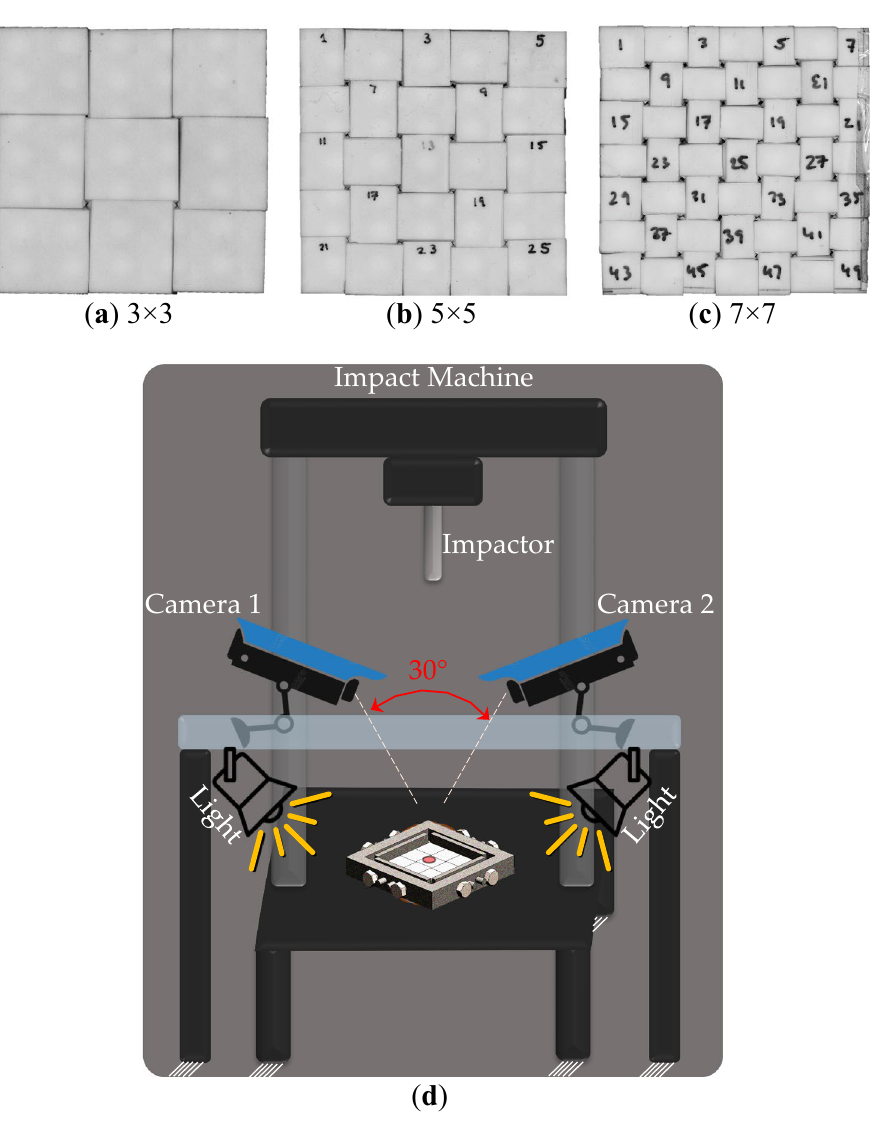
Figure 3. Topologically interlocked ceramics: ( a ) 3 × 3, ( b ) 5 × 5, ( c ) 7 × 7 arrays of blocks (30°), and ( d ) low- velocity impact test and DIC